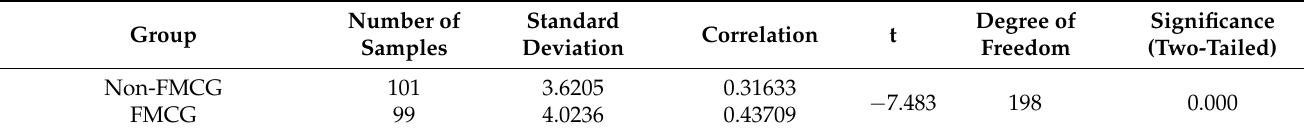
Table 10. The impact of different promotional product types in time-limited promotions on downward anticipated regret.